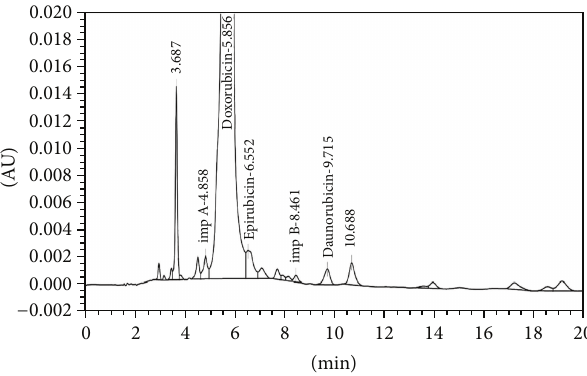
Figure 12: HPLC profile of unirradiated epidoxorubicin.